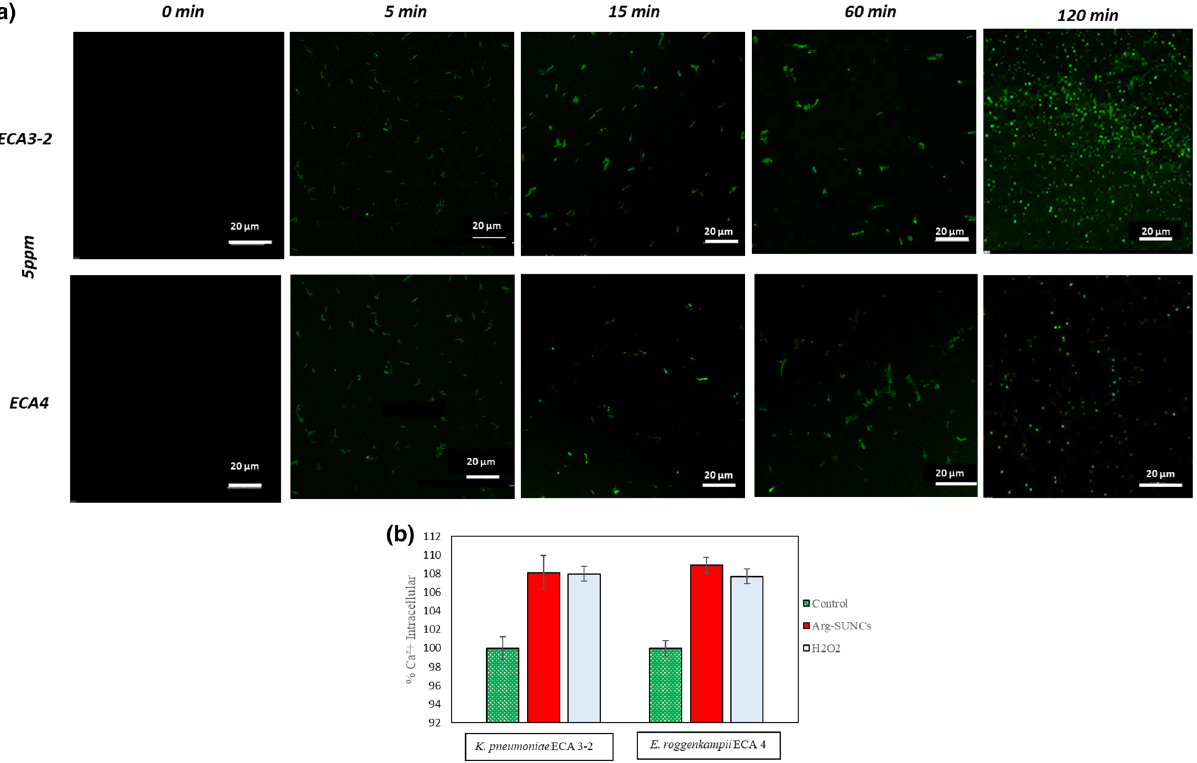
Figure 4. Effect of Arg-SUNCs on membrane depolarization ( a ) and intracellular calcium level ( b ). Cell were incubated for 0, 5, 15, 60 and 120 min with Arg-SUNCs then stained with DiBAC4. Calcium level, was measured with using Fura-2AM. The data represents the average standard deviation and p values.